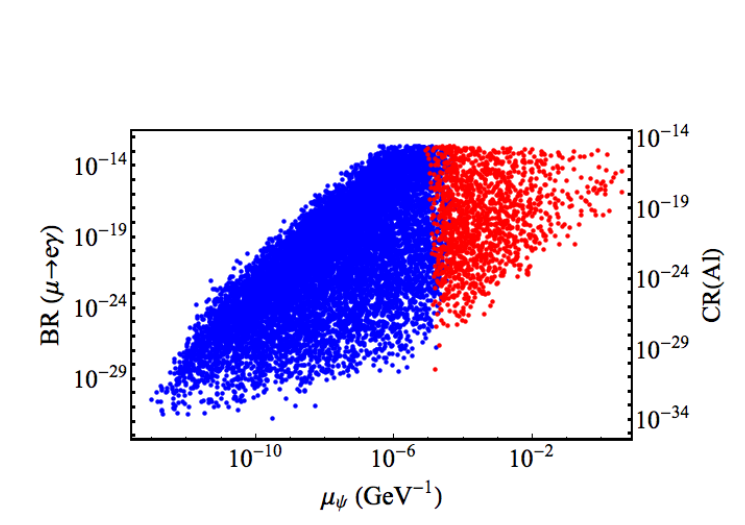
Figure 12 . Branching ratio of (cid:22) e(cid:13) (left axis) and the (cid:22) e conversion ratio in Al (right axis) ! (cid:0) versus the dark matter magnetic dipole moment (cid:22) relevant for DM direct detection. We plot in red (blue) the points that are excluded (allowed) by DM direct detection